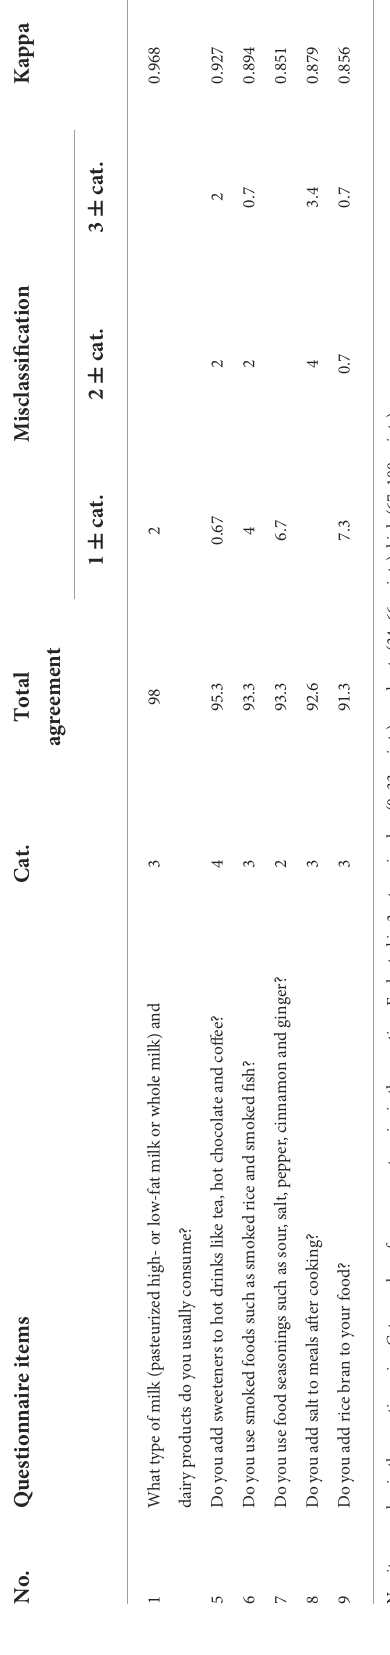
SRMR = 0.031). All factor loadings of items on the FFC Figure